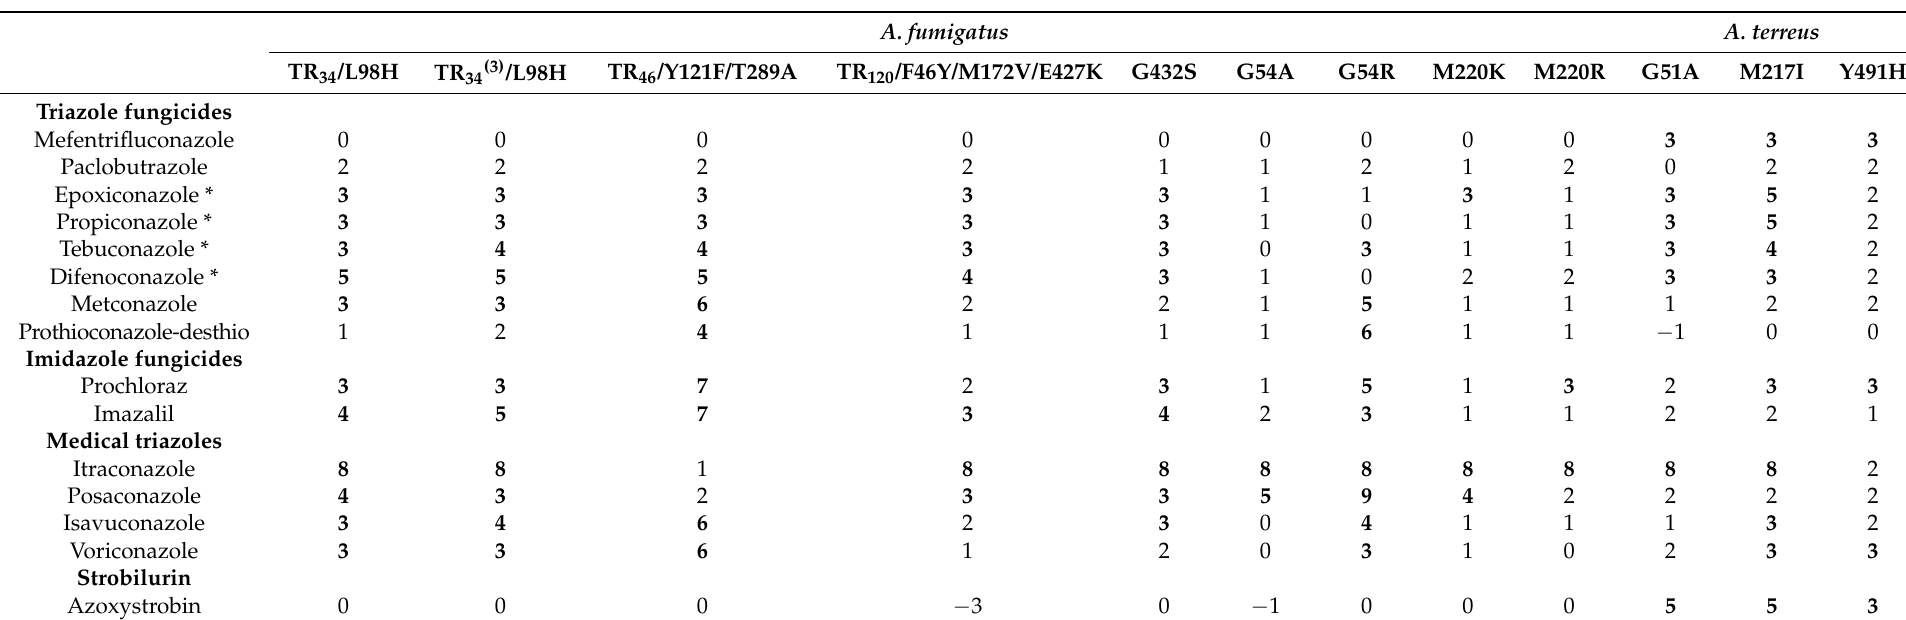
Table 2. Relative susceptibility of mutant isolates compared to same species wild-type isolates determined as Log2(mutant MIC 50 ) – Log2(wild-type MIC). Only agents with activity against wildtype isolates are included. Differences of ≥ 3 Log2 MICs are highlighted in bold, and of ≥ 4 Log2 MICs are underlined. Negative values represent cases where the mutant isolate is more susceptible than its wild-type